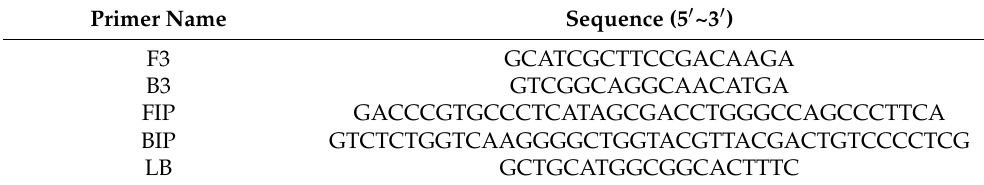
Table 3. Primers used for the LAMP assays to detect A. fabacearum.